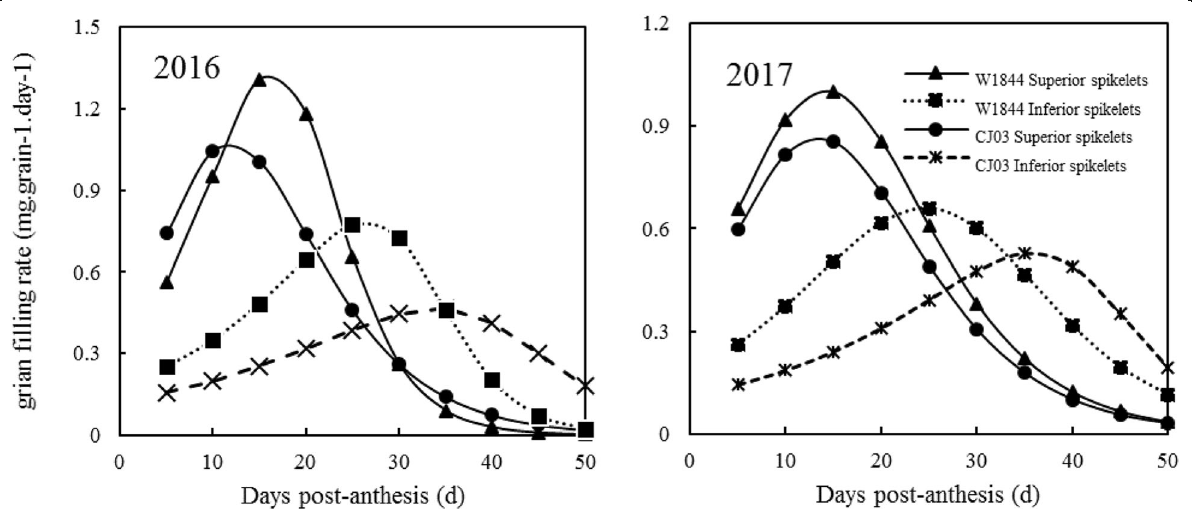
Fig. 4 Changes in grain filling rate of the test materials during the grain filling period in 2016 and 2017. Values are means ± SE ( n =